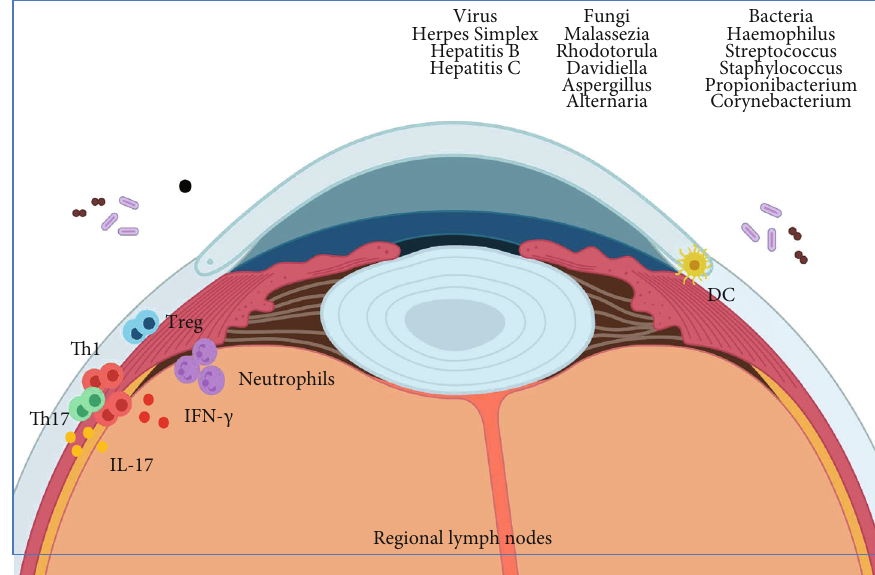
Figure 1: Ocular microbiota. The eye and its components, such as conjunctiva, surrounding skin, and lashes, contained a plethora of microorganisms composing the microbiota of this organ. Several families of virus, fungi, and bacteria are present in distinct areas, and their homeostasis with the host cells is pivotal to keep this zone healthy. Immune components are present as well, with proin fl ammatory cytokines such as IFN- γ and IL-17, and leucocytes like DC, Th1, Th17, Treg, and neutrophils as important factors involved in dysbiosis and eye